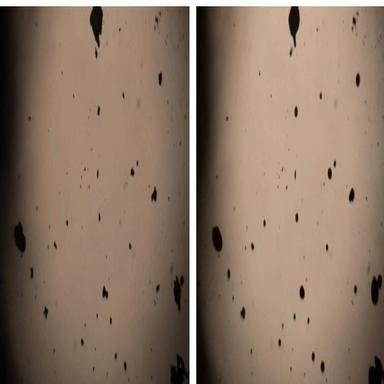
Images captured under the optical microscope: a) start of heating and b) start of the melting phase.